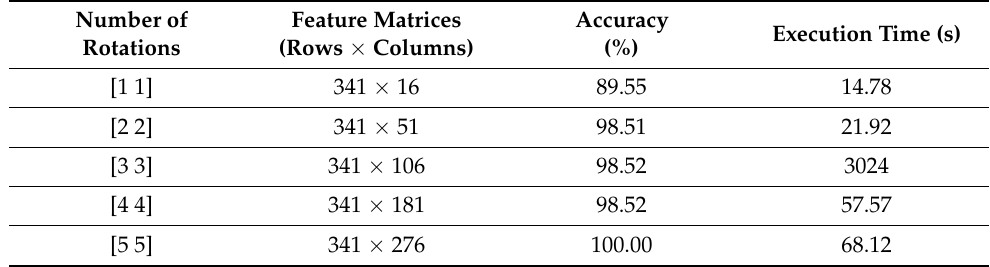
Table 3. Evaluation of number rotations and SVM Model Accuracy.